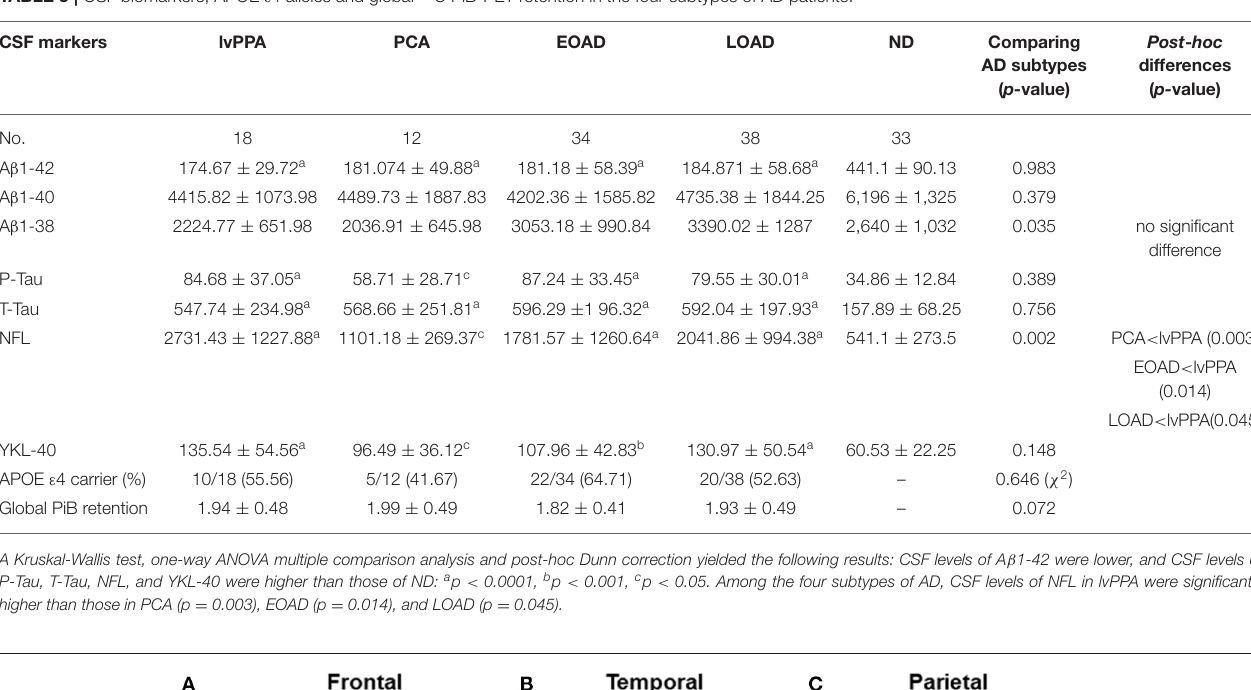
TABLE 5 | CSF biomarkers, APOE ε 4 alleles and global 11 C PiB-PET retention in the four subtypes of AD patients.